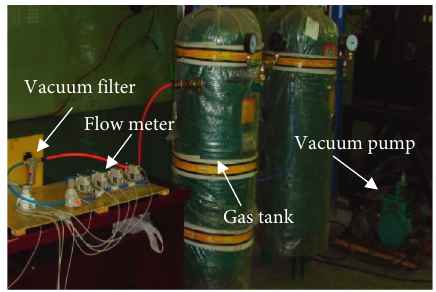
Figure 4: Suction system.